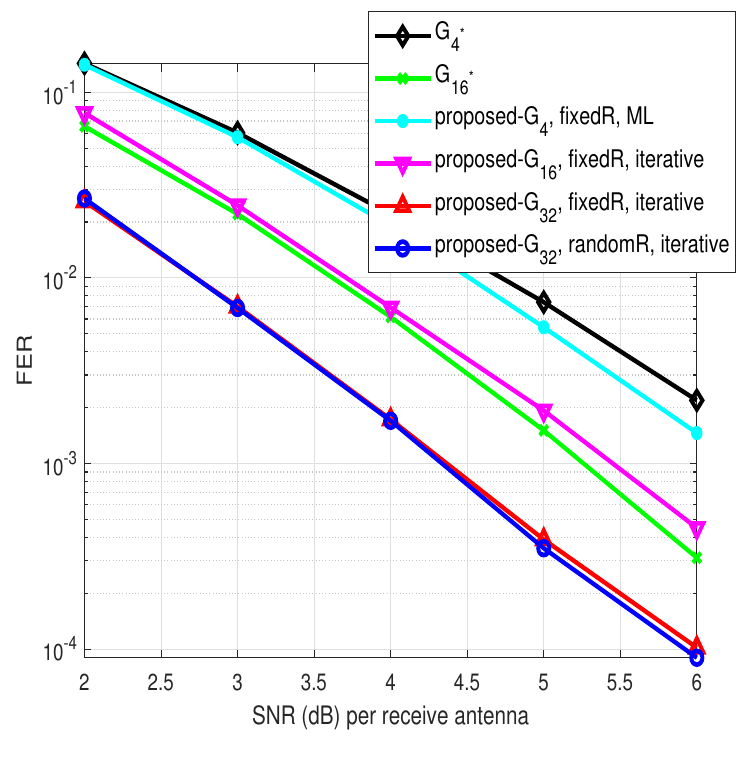
Figure 9. Performance of the proposed scheme based on BPSK − modulated STTC, M T = 2, M R = 2, L = M = 3.